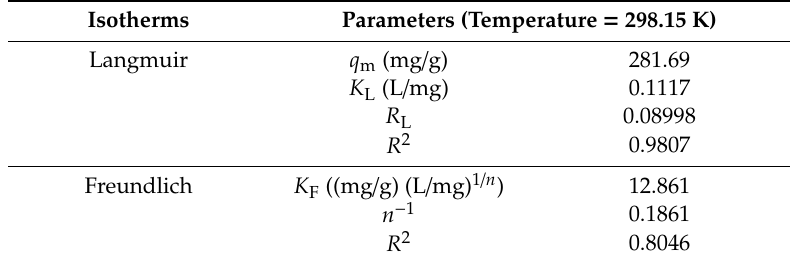
Table 5. Langmuir and Freundlich isotherm constants for adsorption of Pb(II) onto SPEN-CTAB-0%.